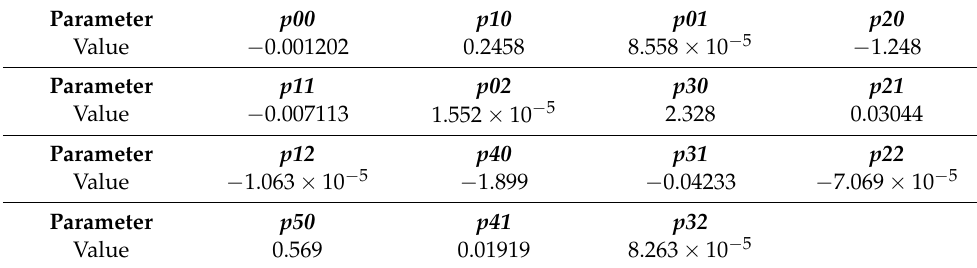
Table 2. Correlation parameters between OCV bias component and